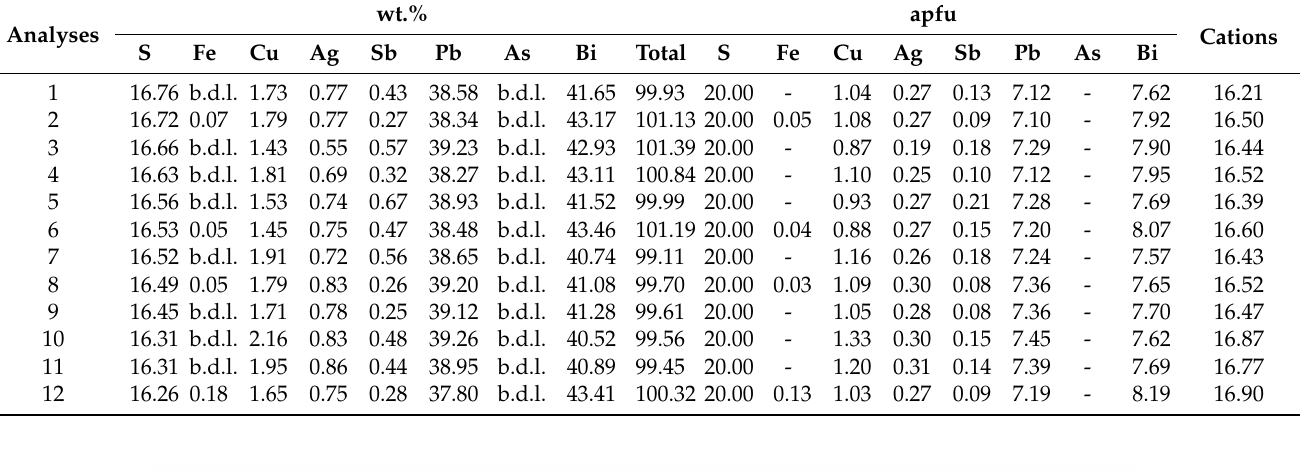
Table 2. Representative EPMA data for cosalite from the Kizhnica quarry. The empirical formula was calculated based on the 20 anions, b.d.l. = below detection limit.